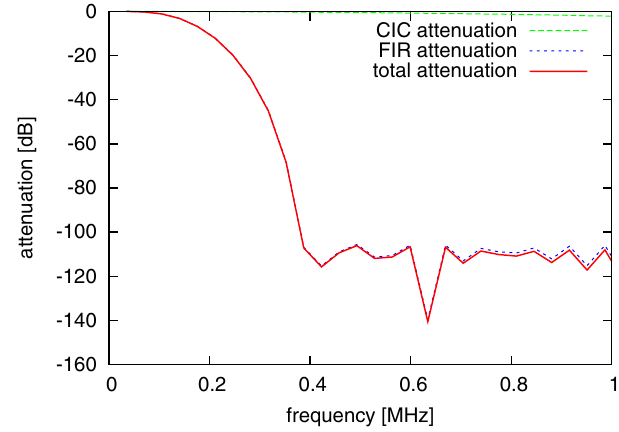
FIG. 10. Frequency response of the LPF in the harmonic- detection block (magnified). The attenuation at 470 kHz is more than (cid:1) 100 dB .